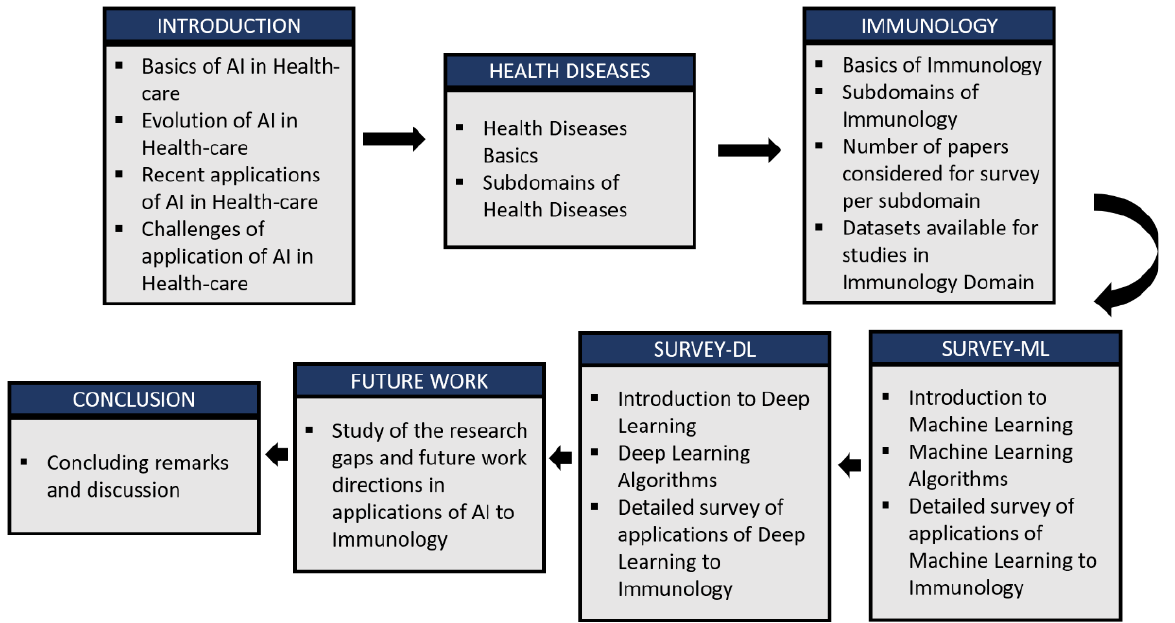
Figure 2. The roadmap representation of the undertaken